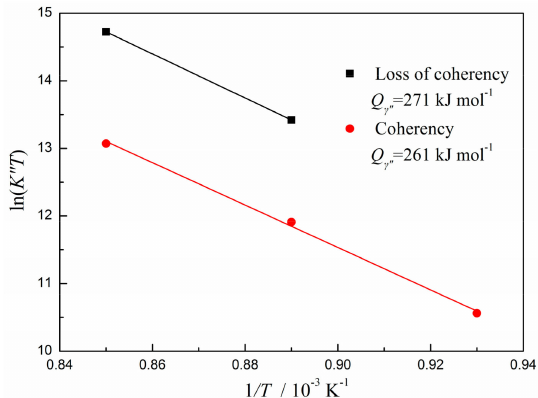
Figure 9. Determination of the activation energies of γ ” phase before and after the coherence and non-coherence transition in